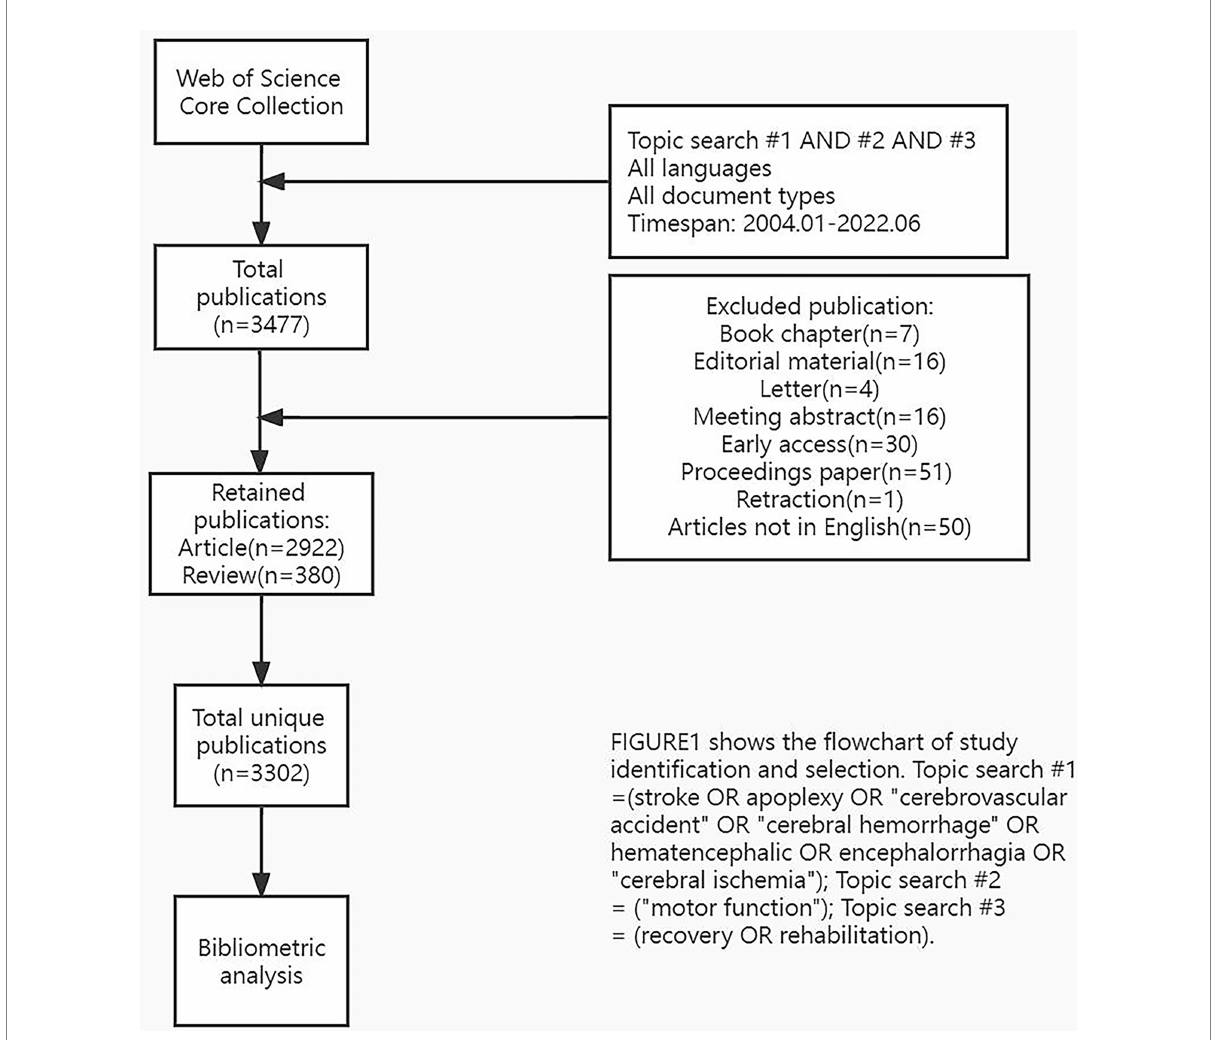
FIGURE 1 The flowchart of study identification and